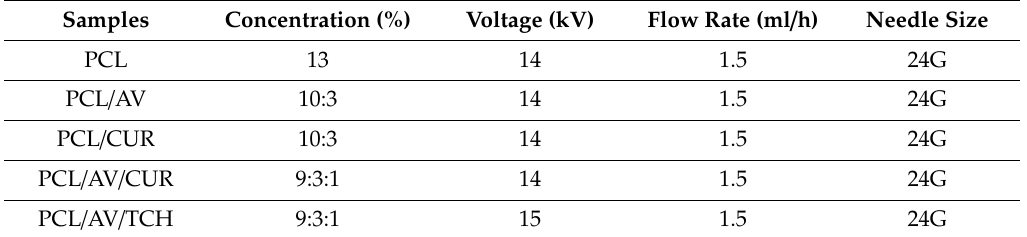
Table 3. Parameters applied for the fabrication of electrospun hybrid nanofibers. Samples Concentration (%) Voltage